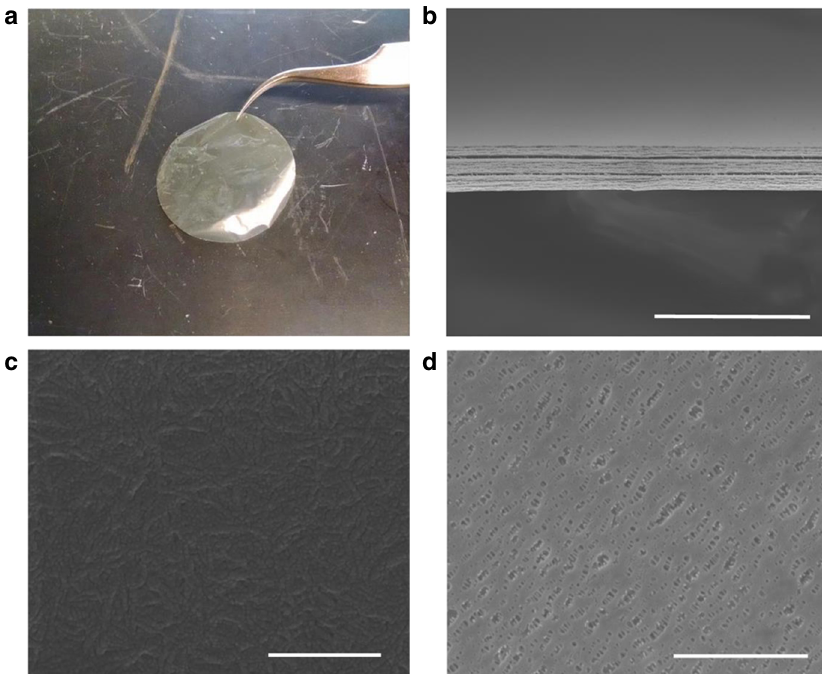
Fig. 1 Images of the ANF and Celgard separators. a Optical image of a neat aramid nano fi bre (ANF) separator. b Cross-sectional scanning electron microscopy (SEM) image of a neat ANF separator. c SEM image of the surface of a neat ANF separator. d SEM image of the surface of Celgard 2325. Scale bars represent 30 μ m in ( b ), 500 nm in ( c ) and 3 μ m in ( d